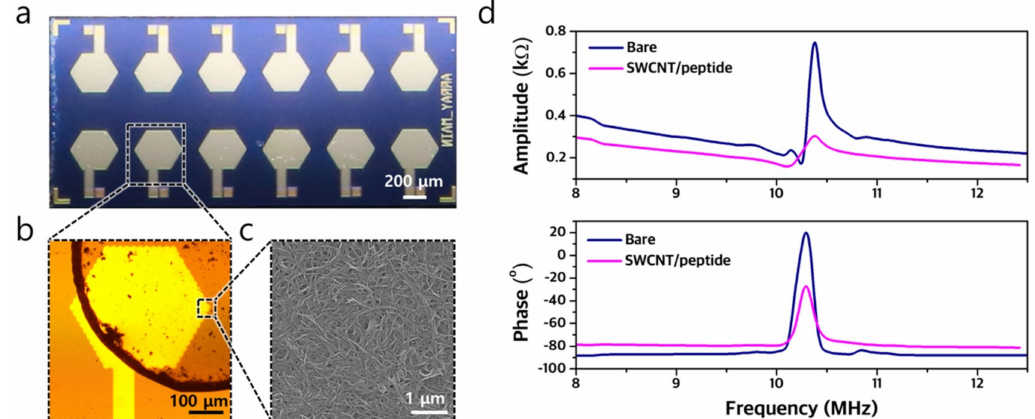
Figure 5. ( a ) Optical image of the fabricated array of CMUT devices. ( b ) Optical image of a single CMUT device coated with a 50-nm-thick SWCNT/peptide layer. ( c ) SEM image of SWCNT/peptide layer coated on top of the CMUT sensor. ( d ) Plot of input impedance (amplitude and phase) of the CMUT device biased at 6.2 V before and after the coating of